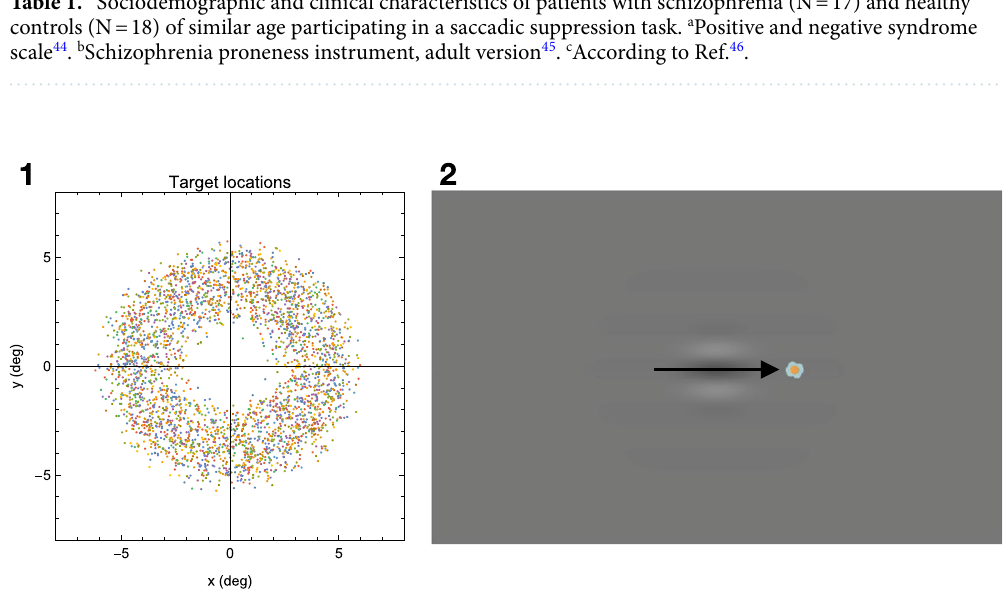
Figure 1. (1- 1 ) Summary of target locations across all trials and participants (indicated by different colors). The distance between two successive target locations was always 7°. (1- 2 ) Example of a saccadic suppression trial with a probe displayed by a Gabor appearing halfway (3.5°) along the saccade trajectory (depicted as arrow). Gabor grating was oriented parallel to saccade